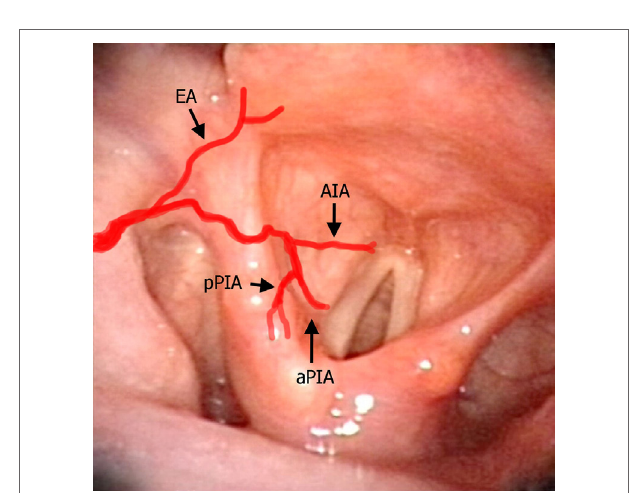
Figure 7 | Laryngeal videoendoscopy simulating the intraoperative transoral surgical perspective, with superimposed red lines schematically representing the laryngeal arteries described in the text. Abbreviations: EA, epiglottic artery; AIA, antero-inferior artery; aPIA, anterior branch of the postero-inferior artery; pPIA, posterior branch of the postero-inferior